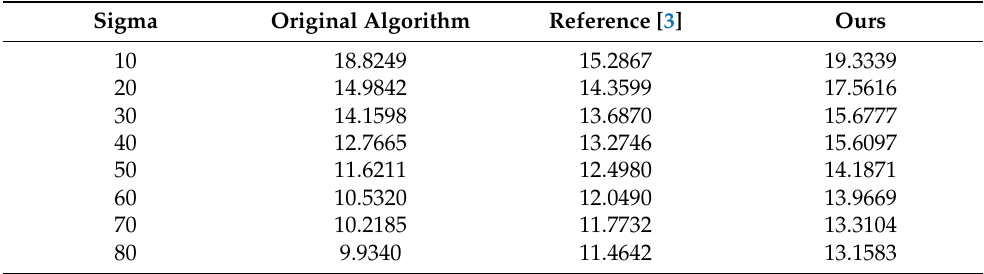
Table 2. Peak signal-to-noise ratio (SNR) of the three algorithms for the Cameraman image.